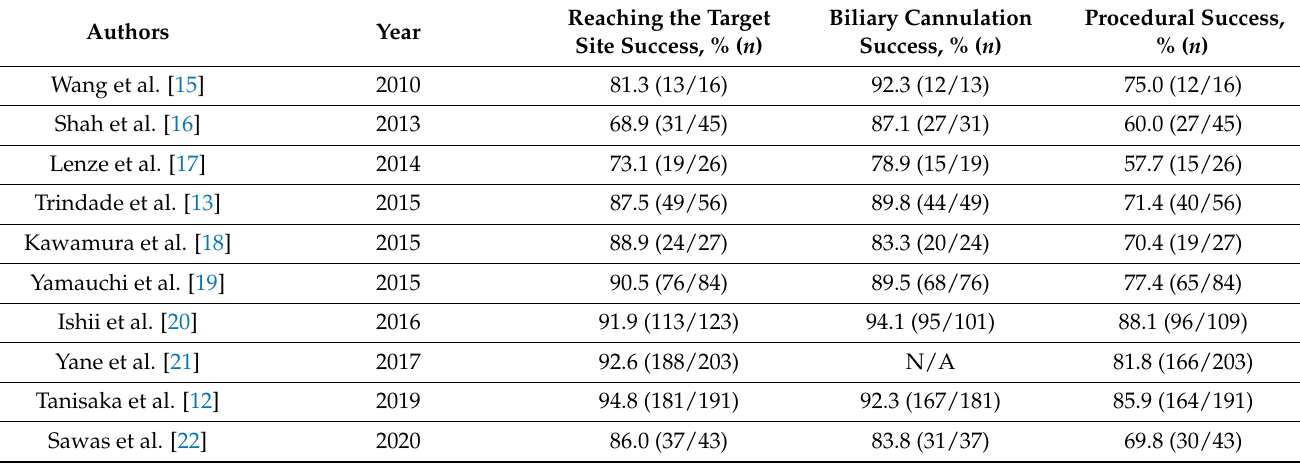
Table 2. Outcomes of single balloon enteroscopy (SBE)-assisted endosopic retrograde cholangiopancreatography (ERCP) procedure in patients with surgically altered anatomy